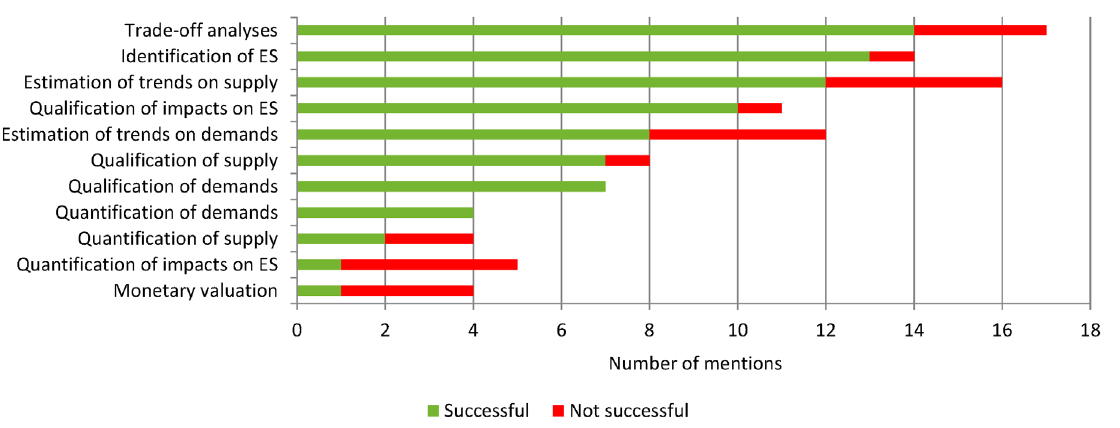
Figure 3: Type of information that has been asked from stakeholders (102 mentions, multiple answers